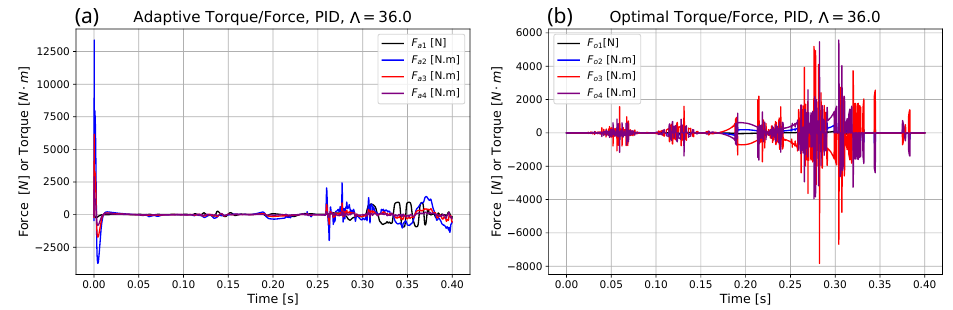
Figure 26. The control forces with force limitation ∆ u = 495.0 N or N · m for the increased α min = 0.1. ( a ) The adaptive control forces. ( b ) The optimized forces.